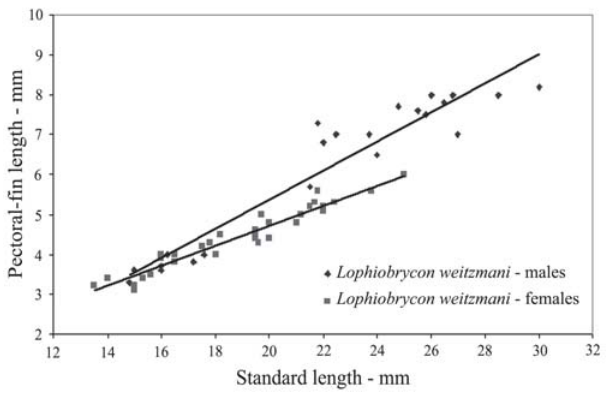
Fig. 9. Lophiobrycon weitzmani . Pectoral-fin length as function of standard length for males and females.